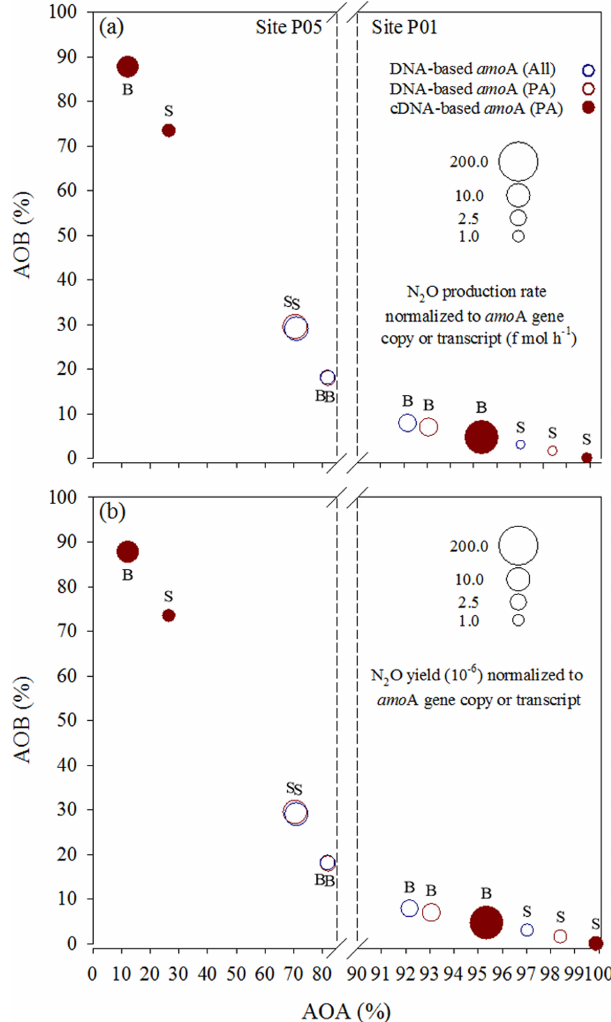
Figure 7. N 2 O (a) production rates and (b) yields normalized to total amoA gene copy or transcript numbers of AOA and AOB in a given sample. They are presented along the x – y axes that repre- sent the relative contributions of AOA and AOB to the total amoA gene or transcript pools. S: surface; B: bottom. All, sum of free- living and particle-associated communities; PA, particle-associated